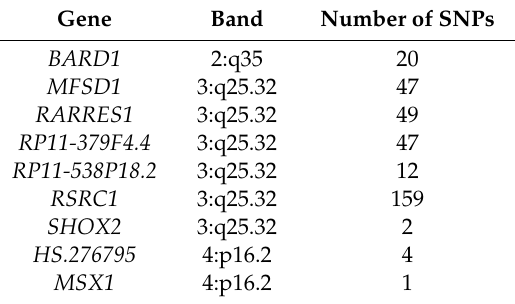
Figure 3. Box plots represent the distribution of overlap of the epigenetic feature under consideration with random sets of markers matched to the real set in terms of numerosity and LD structure. The bar inside each box corresponds to the median enrichment score of the null set. Whiskers span from minimum value to first quartile and from third quartile to maximum value. Dots represent the estimated enrichment in the real set of SNPs considered. One feature still significant after stringent multiple testing correction (Bonferroni corrected p -value < 0.01) is marked in red. Table 6. eQTL mapping performed in shared and colocalizing susceptibility loci.